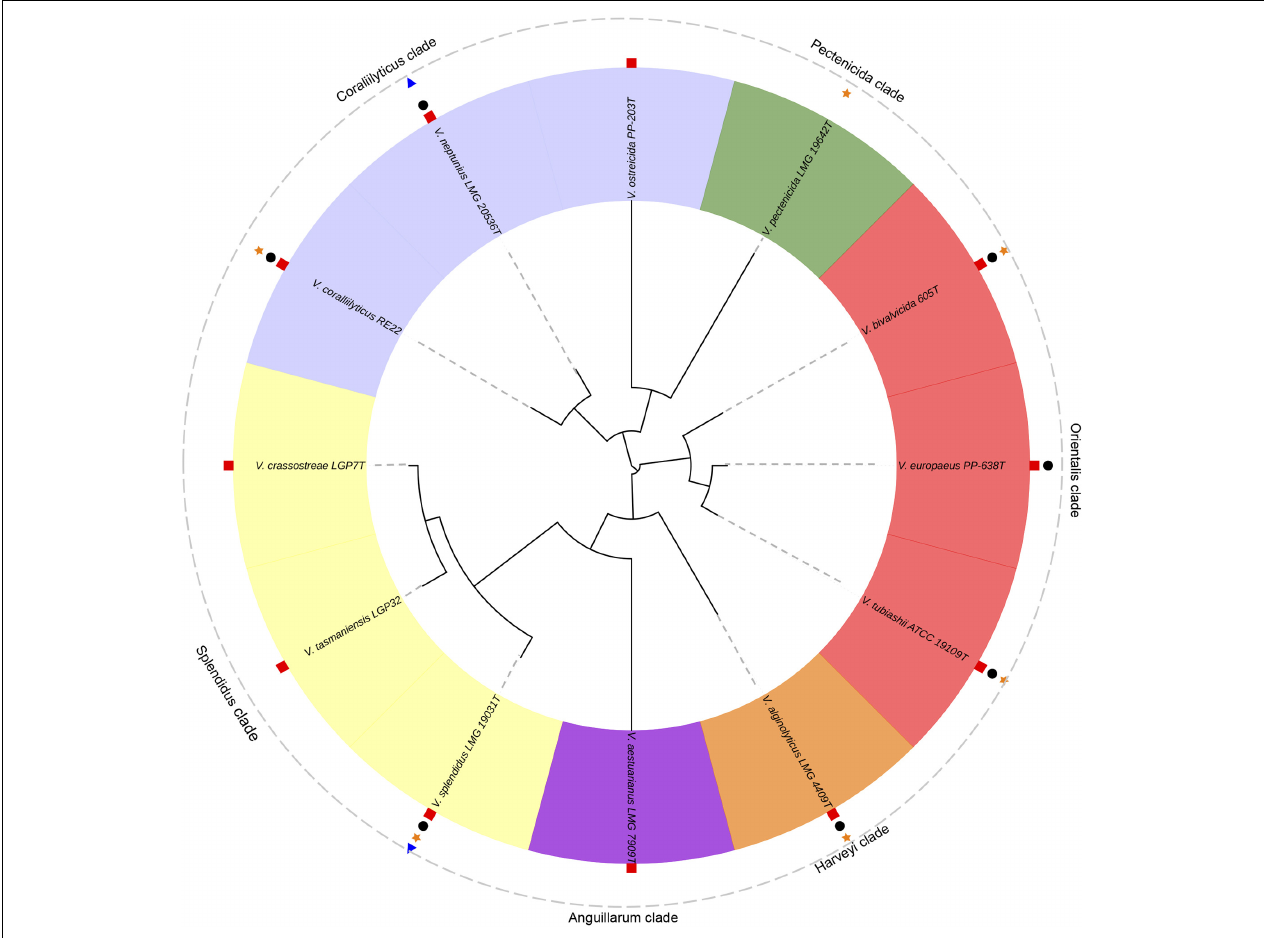
FIGURE 3 | Phylogenetic tree of the pathogenic Vibrio species responsible of outbreaks in bivalve hatcheries. V. tasmaniensis and V. crassostreae, well-known pathogenic species for spat and juveniles in the natural environment, were also included. Analyses were based on the concatenation of the partial sequences of five housekeeping genes ( gyr B, fts Z, pyr H, rec A and rpo A; 3073 bp) after multiple data alignment with MUSCLE software using ML algorithm (GTR+G model). Symbols show the pathogenicity of these species for larvae and/or spat of: oysters (red squares), clams (black circles), scallops (orange stars) and mussels (blue